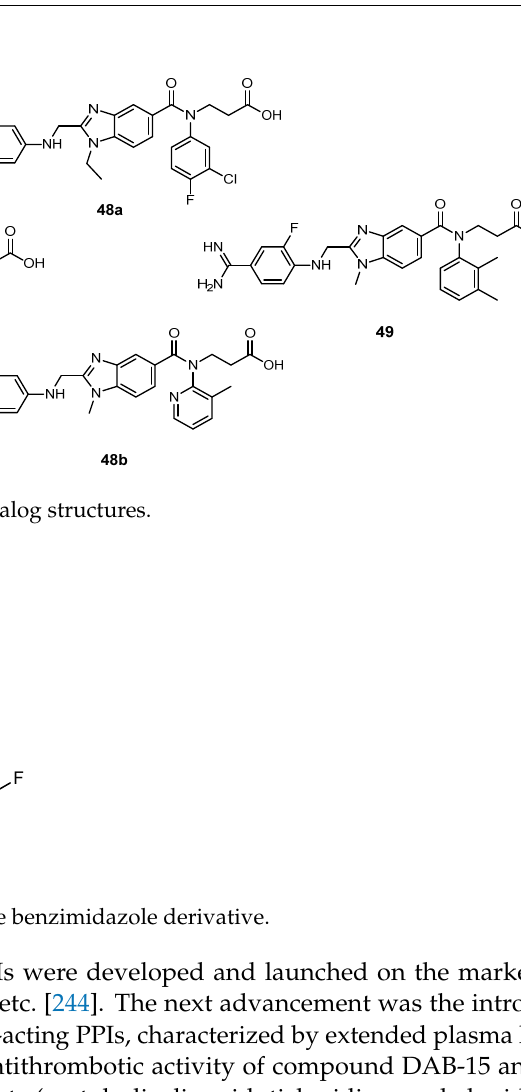
Figure 24. Quinolinyl oxadiazole benzimidazole derivative.